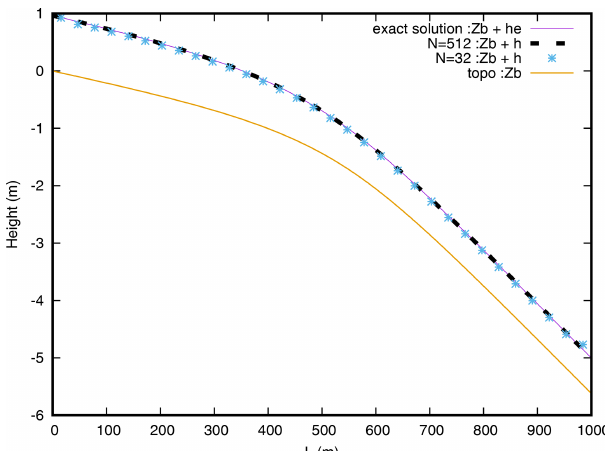
Figure 3. Comparison of the water height profiles between the sim- ulation with the analytical solution of the Manning friction test case for two different resolutions.